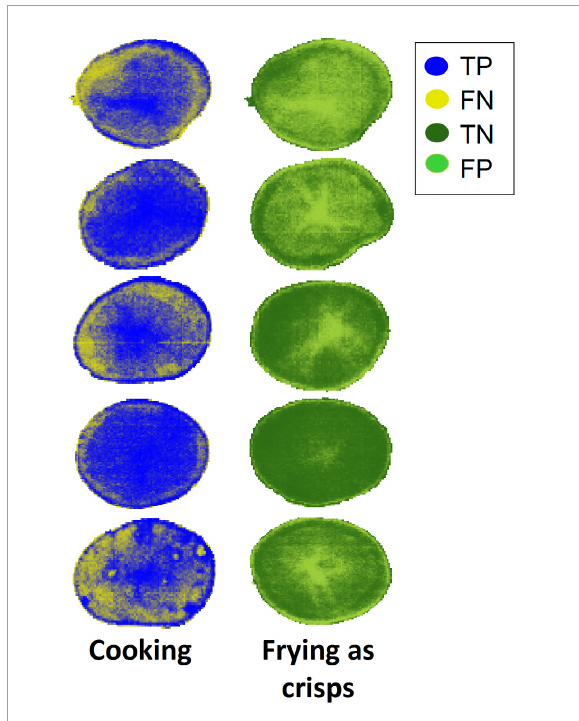
FIGURE5 Classification maps for the validation dataset obtained by the PLS-DA model built from 1D+MSC+MC pre-processed spectra (1D+MSC+MC of Table 6 ) in the pixel-wise classification